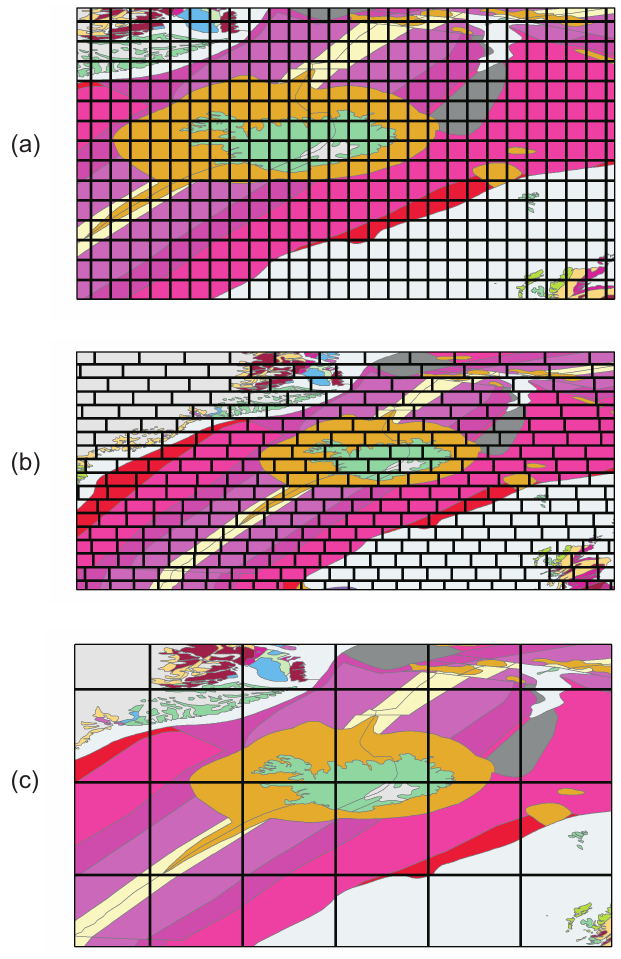
Fig. 6. Presentation of CCGM Geology, focussed on the North At- lantic, together with 3 different grids: (a) 1 degree equal longitude grid; (b) 1 degree equal area grid; and (c) 5 degree equal longitude